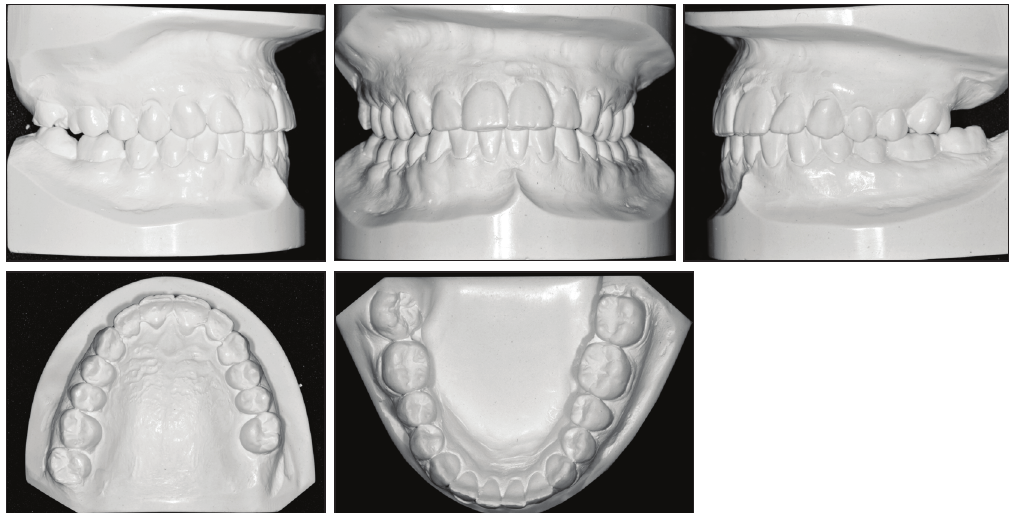
Figure 11. Photographs of dental casts immediately after debonding of all